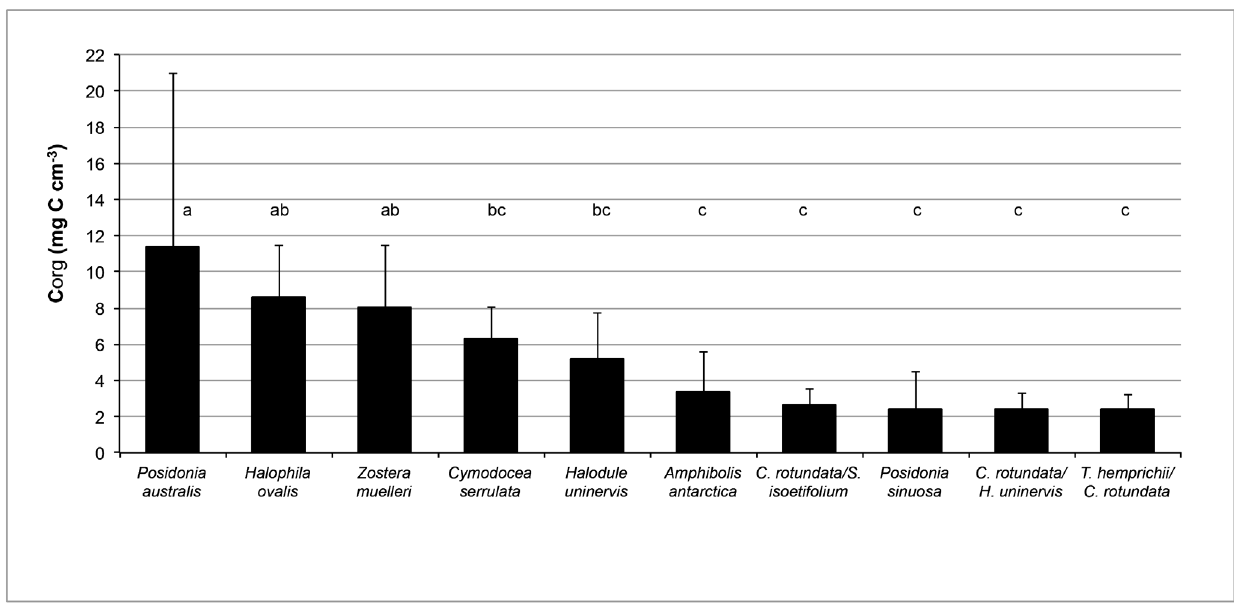
Figure 1. Organic carbon stocks (Mean ± SD) in the top 25 cm of sediment cores from different Australian seagrass meadows. Shared letters above the bars indicate no significant difference (p . 0.05) among habitats.